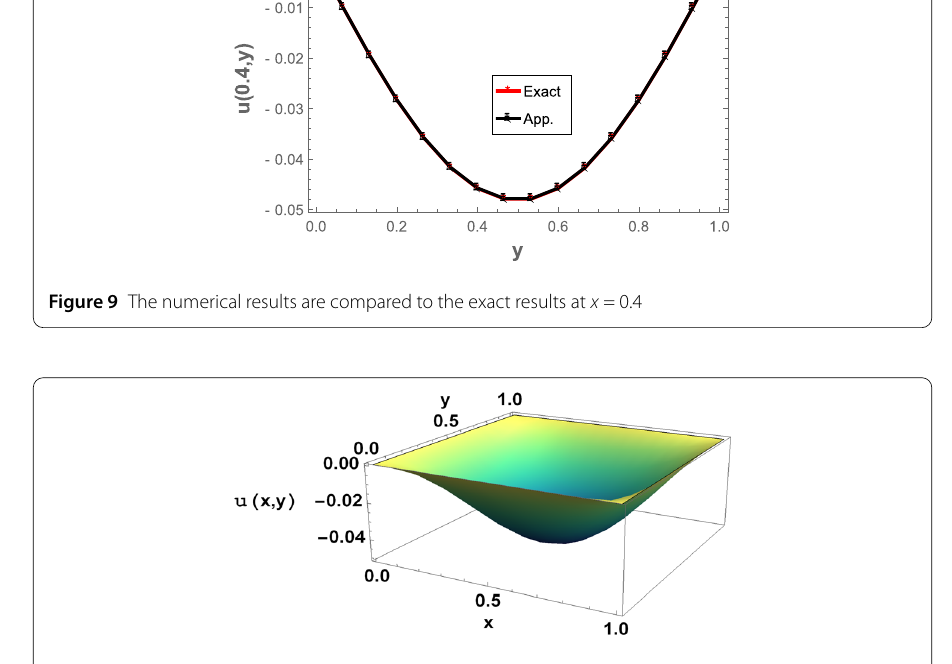
Table 4 present the results of the two-dimensional trigonometric cubic B-spline tech- nique at 15 × 15. In terms of results, we can assume that the results are acceptable. Figures 8 and 9 display the numerical results with exact results at y = 0.4. The three- dimensional graph for numerical results is shown in Fig.